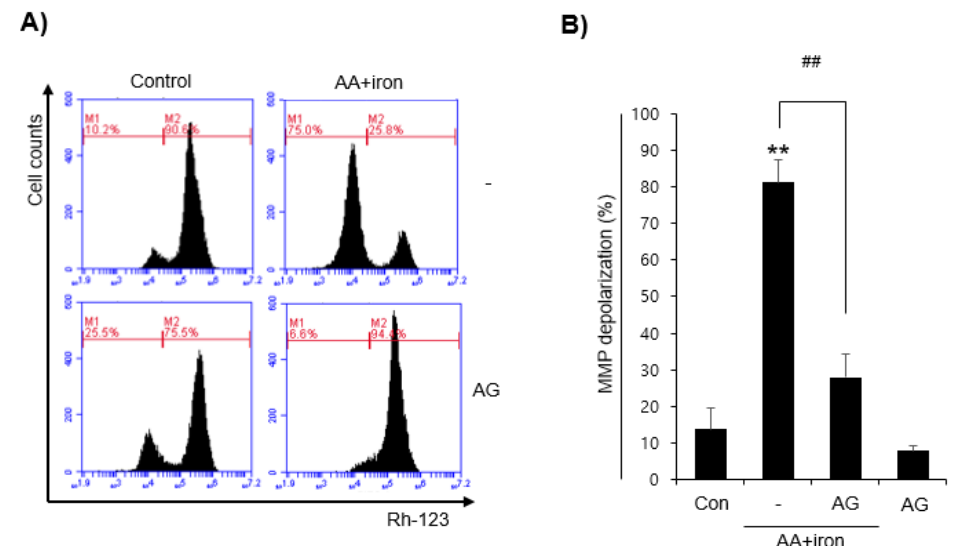
Figure 2. Effects of AG on the mitochondrial membrane potential (MMP) ( A ) Mitochondria protective effect of AG by flow cell analysis. HepG2 cells were treated as described in Fig. 1. The cells were then incubated with Rh 123 (0.05 µ g/mL) for 1 h. ( B ) Relative proportion of low Rh 123 intensity was expressed as the mean ± SD of three independent experiments (** p < 0.01 vs. control group; ## p < 0.01 vs. AA+iron-treated group). AA, arachidonic acid; AG, Angelica gigas NAKAI.